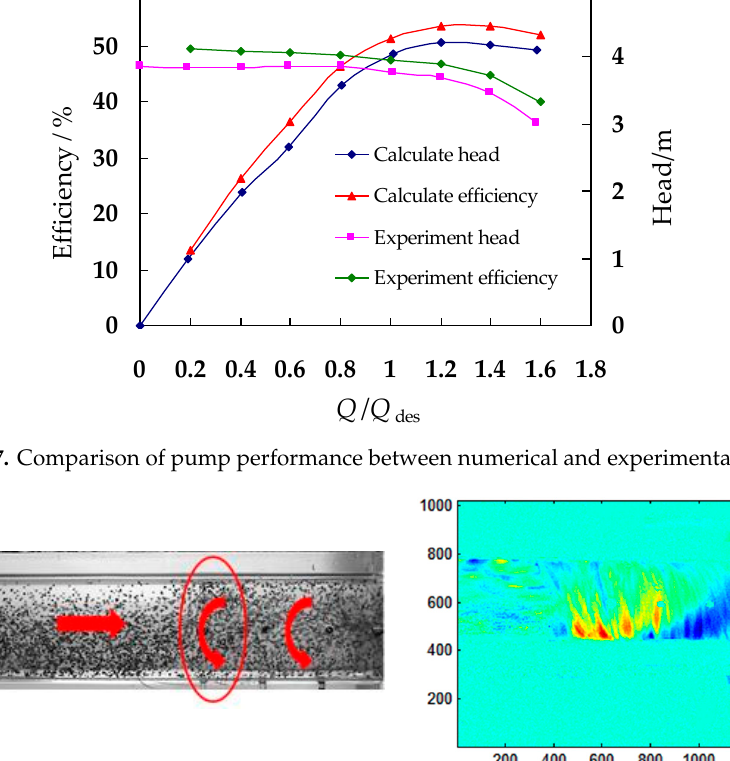
Figure 17. Comparison of pump performance between numerical and experimental results.